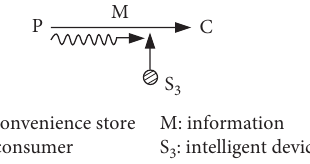
Figure 6: Optimized model of touchpoint of commodity com- petition